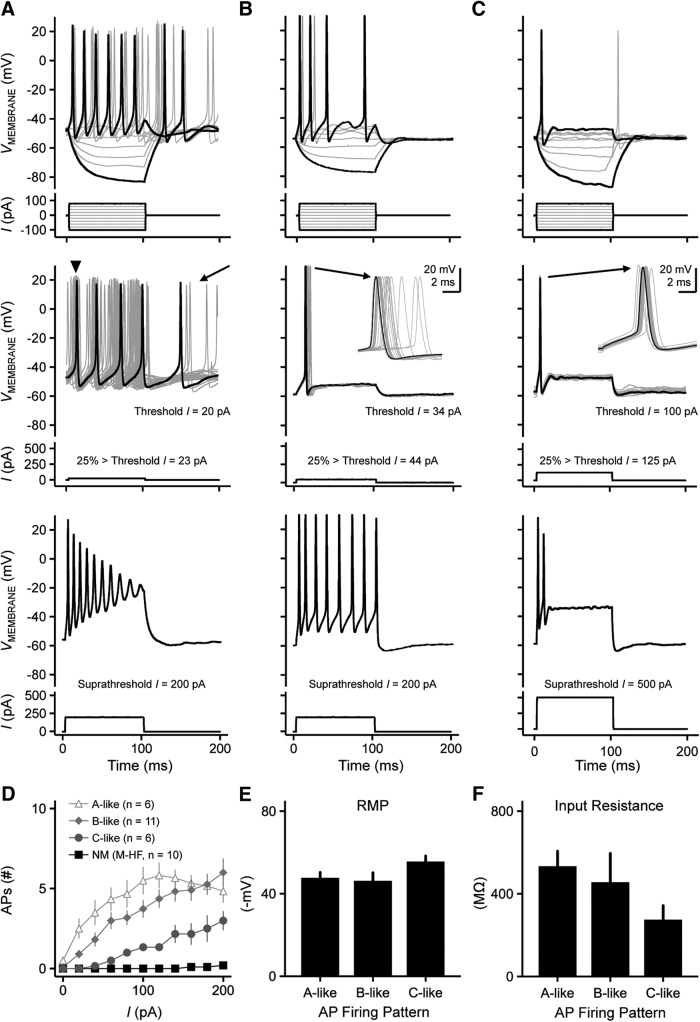
Heterogeneous voltage responses to current injections recorded from NMc1 and NMc2 neurons. A, B, C, (top) Representative voltage responses recorded from three NMc1/NMc2 neurons to current injections from –100 to 80 pA in steps of 20 pA (bottom). (middle) Representative voltage responses (30 superimposed trials) recorded from the same three NMc1/NMc2 neurons shown in the top panel, respectively. Bottom, current injections with the strength 25% above threshold current. Arrowhead in A shows widespread AP peak occurrences for this neuron. Arrow in A shows spontaneous activity. Insets in B and C show the enlargement of 30 superimposed APs. (bottom) Representative voltage responses recorded from three NMc1/NMc2 neurons to current injections with the strength of 200 pA (A and B) or 500 pA (C). D, Population data showing the number of APs elicited as a function of current injections from 0 to 200 pA, steps of 20 pA. NMc1/NMc2 neurons are divided into three subgroups: neurons displaying voltage responses similar to the neurons shown in A, B, and C are noted as A-like, B-like, and C-like, respectively (see Results for objective classification details). Mid- to high-frequency NM neurons (M-HF) are also shown as a reference (data modified from Hong et al., 2016). E, F, Population data showing resting membrane potential (RMP, E) and input resistance (F) of A-like, B-like, and C-like NMc1/NMc2 neurons. The duration of all current injections in this figure is 100 ms. Error bars show SE.